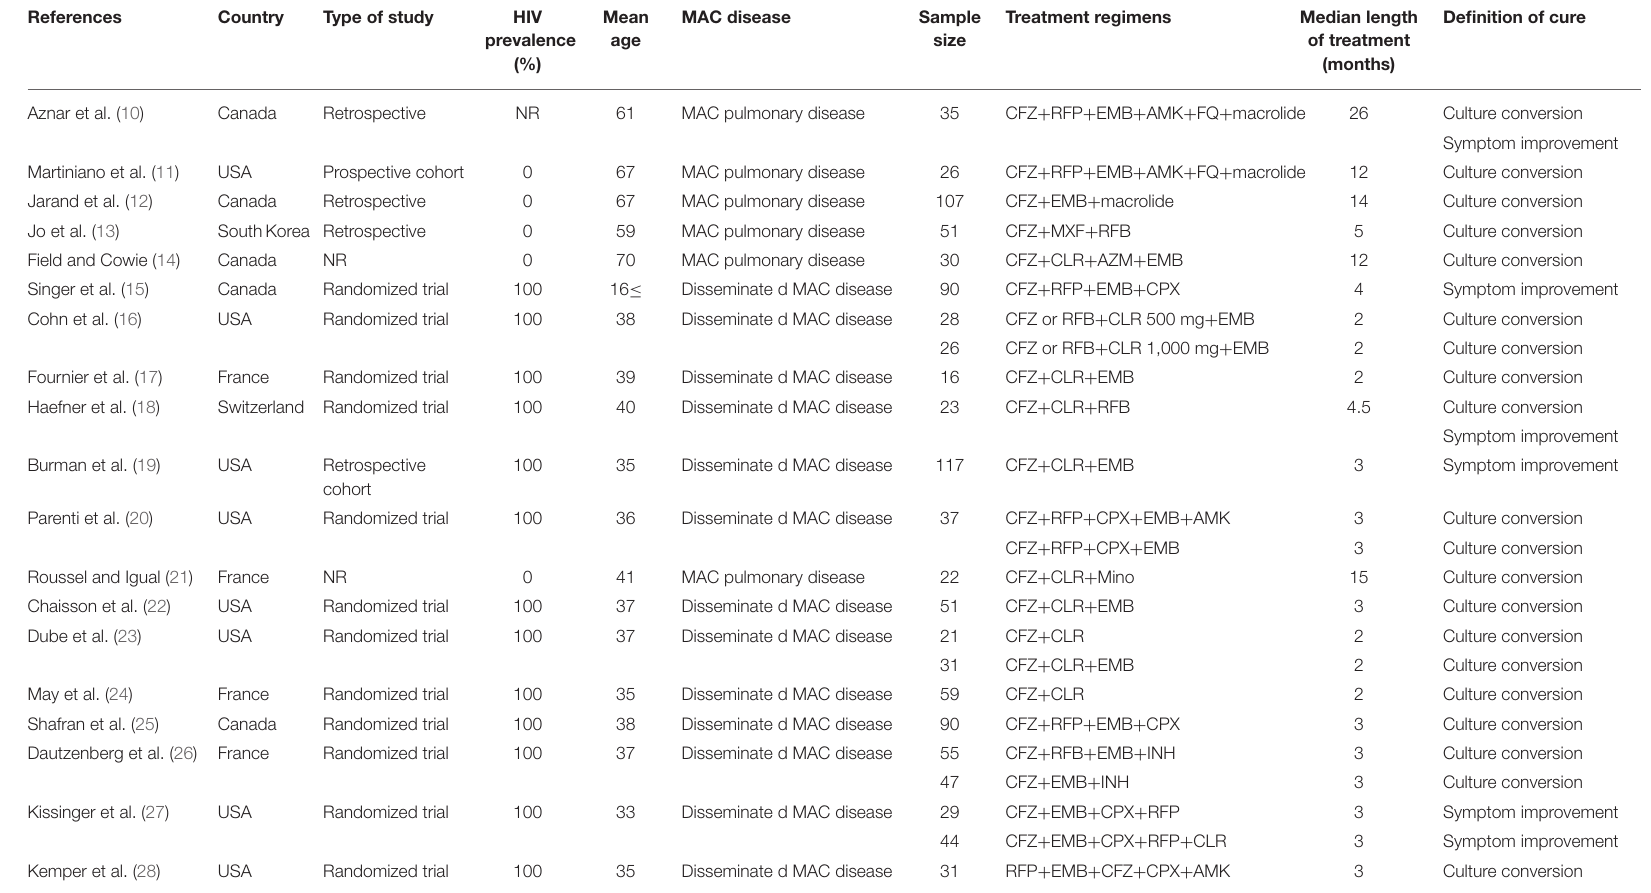
TABLE 1 | Characteristics of studies with clofazimine in their